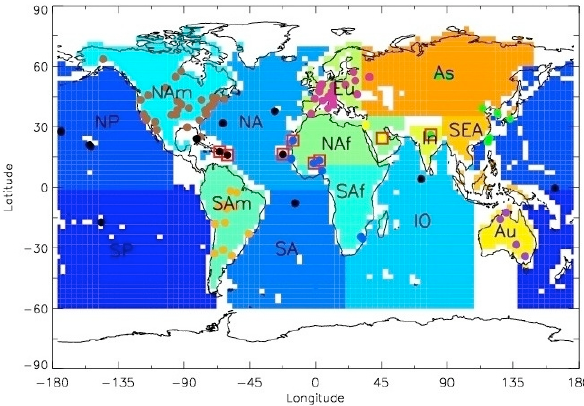
Figure 2. Fig. 2. Location of AERONET stations used in the validation. Red squares correspond to AERONET stations dominated by dust aerosols. Regions used in the validation with respect to MODIS data are also illustrated. AERONET stations are grouped geograph- ically into North America (brown), South America (orange), Eu- rope (pink), Africa (blue), Asia (green), Middle East (yellow) and Australia (purple). Oceanic AERONET stations are illustrated with black